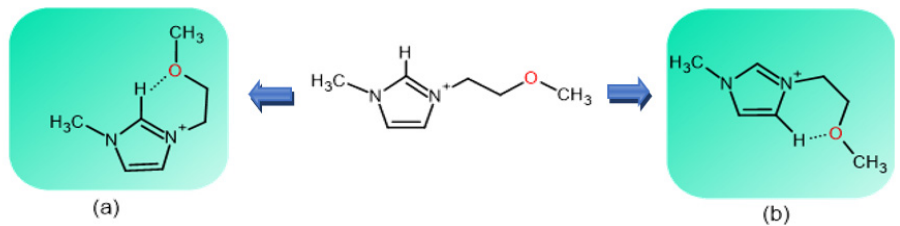
Figure 8. Schematic representation of the MD-based intramolecular hydrogen bonding in 1-(2-meth- oxyethyl)-3-methylimidazolium acetate, between the ether oxygen, C2- H , part ( a ), and C4- H part ( b ) of the 1,3-disubstituted imidazolium ion. This hydrogen bonding “deactivates” the ether oxygen, which is a Lewis base. Figure reproduced with permission from [53]; Elsevier,